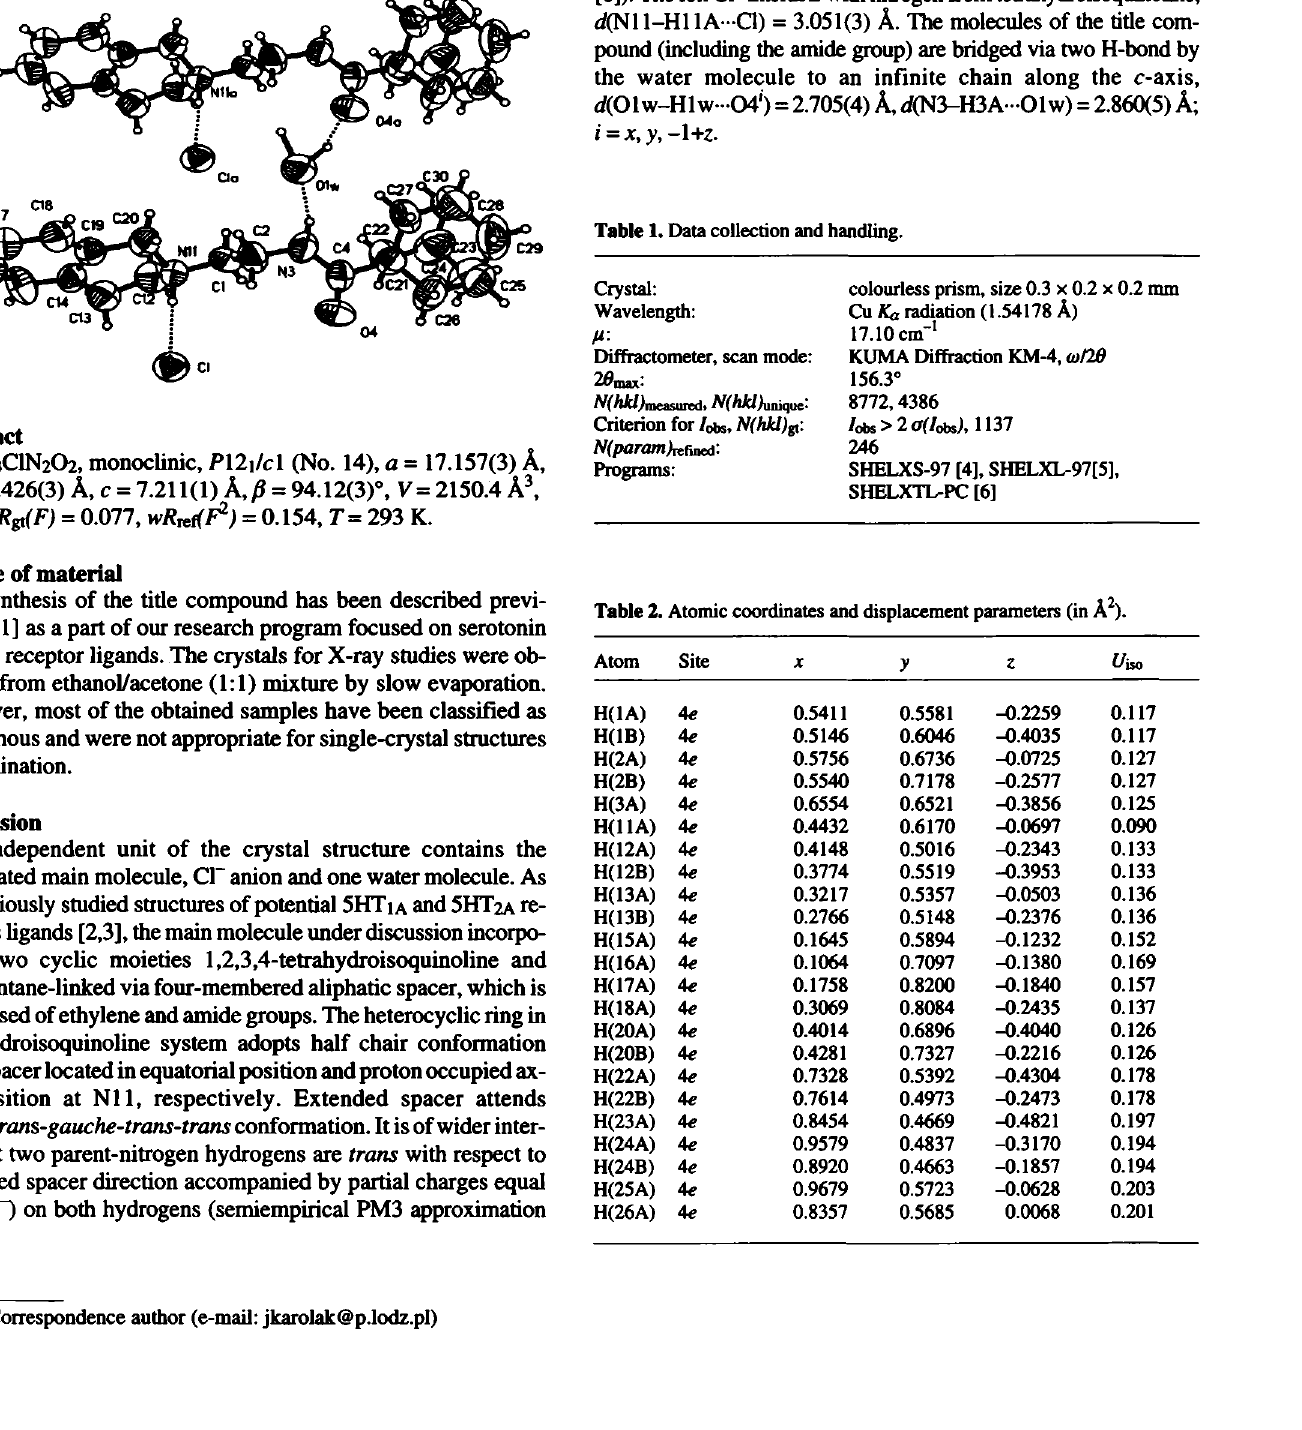
Table 1. Data collection and handling.